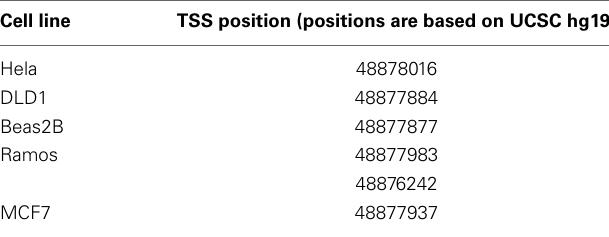
Table 2 | Transcription start sites (TSSs) identified in the DBTSS database for different cell